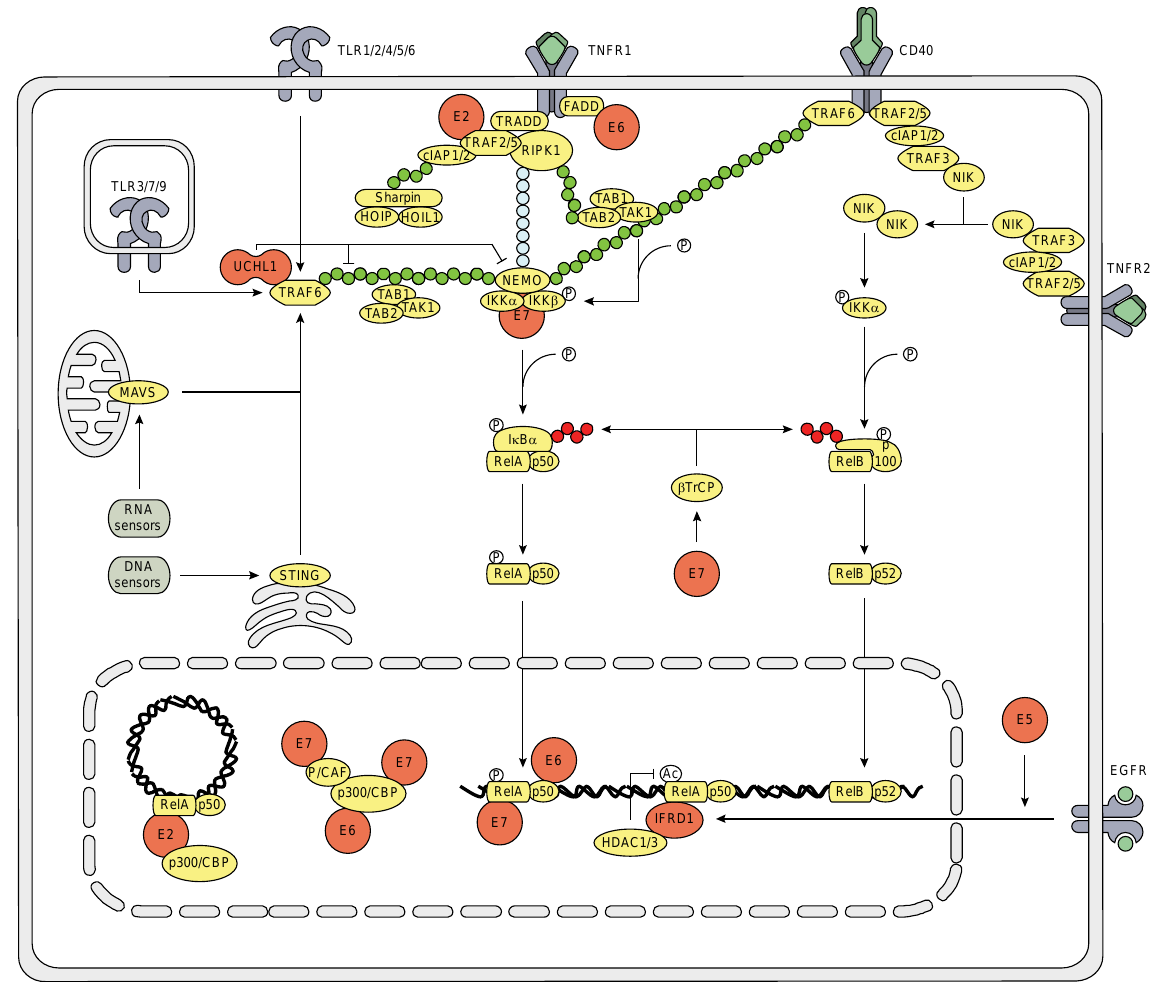
Figure 3. Schematic representation of the effects of hrHPV on NFκB signaling. The canonical NFκB1 pathway is activated by PRRs and CD40 through TRAF6 and TNFR1 through RIP1. Poly-ubiquitination of TRAF6 and RIP1 recruits the TAB1-TAB2-TAK1 and IKK complexes resulting in the phosphorylation of IKKβ by TAK1. IKKβ phosphorylates IκBα, which is then ubiquitinated by SCF-βTrCP and subsequently degraded, and thereby releases the NFκB1 complex to translocate to the nucleus. CD40 and TNFR2 initiate non-canonical NFκB2 signaling by recruitment of TRAF2/5, cIAP1/2 and TRAF3 to the respective receptor, leading to TRAF3 degradation. This causes NIK to accumulate and activate IKKα to phosphorylate p100. This induces SCF-βTrCP to ubiquitinate p100, leading to the proteosomal processing of p100 into p52, and the subsequent nuclear translocation of NFκB2. In the nucleus NFκB binds to the DNA and is aided by coactivators to initiate gene transcription. HPV utilizes its own encoded E proteins (red) as well as exploits the cellular proteins (red) UCHL1 and IFRD1 to interfere with NFκB1 signaling at multiple positions in the pathway. Green circles indicate K63-linked poly-ubiquitin chains, red circles indicate K48-linked poly-ubiquitin chains, and blue circles indicate linear poly-ubiquitin chains.